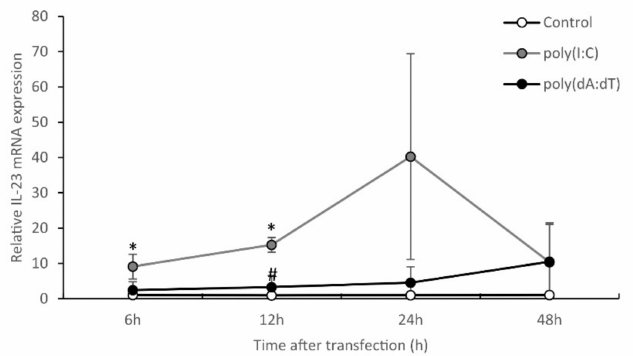
Figure 2. Kinetics of the IL-23 mRNA expression in NHEKs upon nucleic acid induction. Cells were transfected with 0.666 µ g/mL poly(I:C) and 1 µ g/mL poly(dA:dT), and samples were collected at 6, 12, 24 and 48 h after transfection. Relative IL-23 mRNA expression was determined by the ∆∆ Ct method, normalized to GAPDH mRNA expression and compared to the expression of the untreated (Control) 0 h samples. Data are presented as means of three independent experiments ± SD. Significance was determined by one-tailed, paired Student’s t -test, * p < 0.05 poly(I:C)-treated vs. time-matched control samples, # p < 0.05 poly(dA:dT)-treated vs. time-matched control